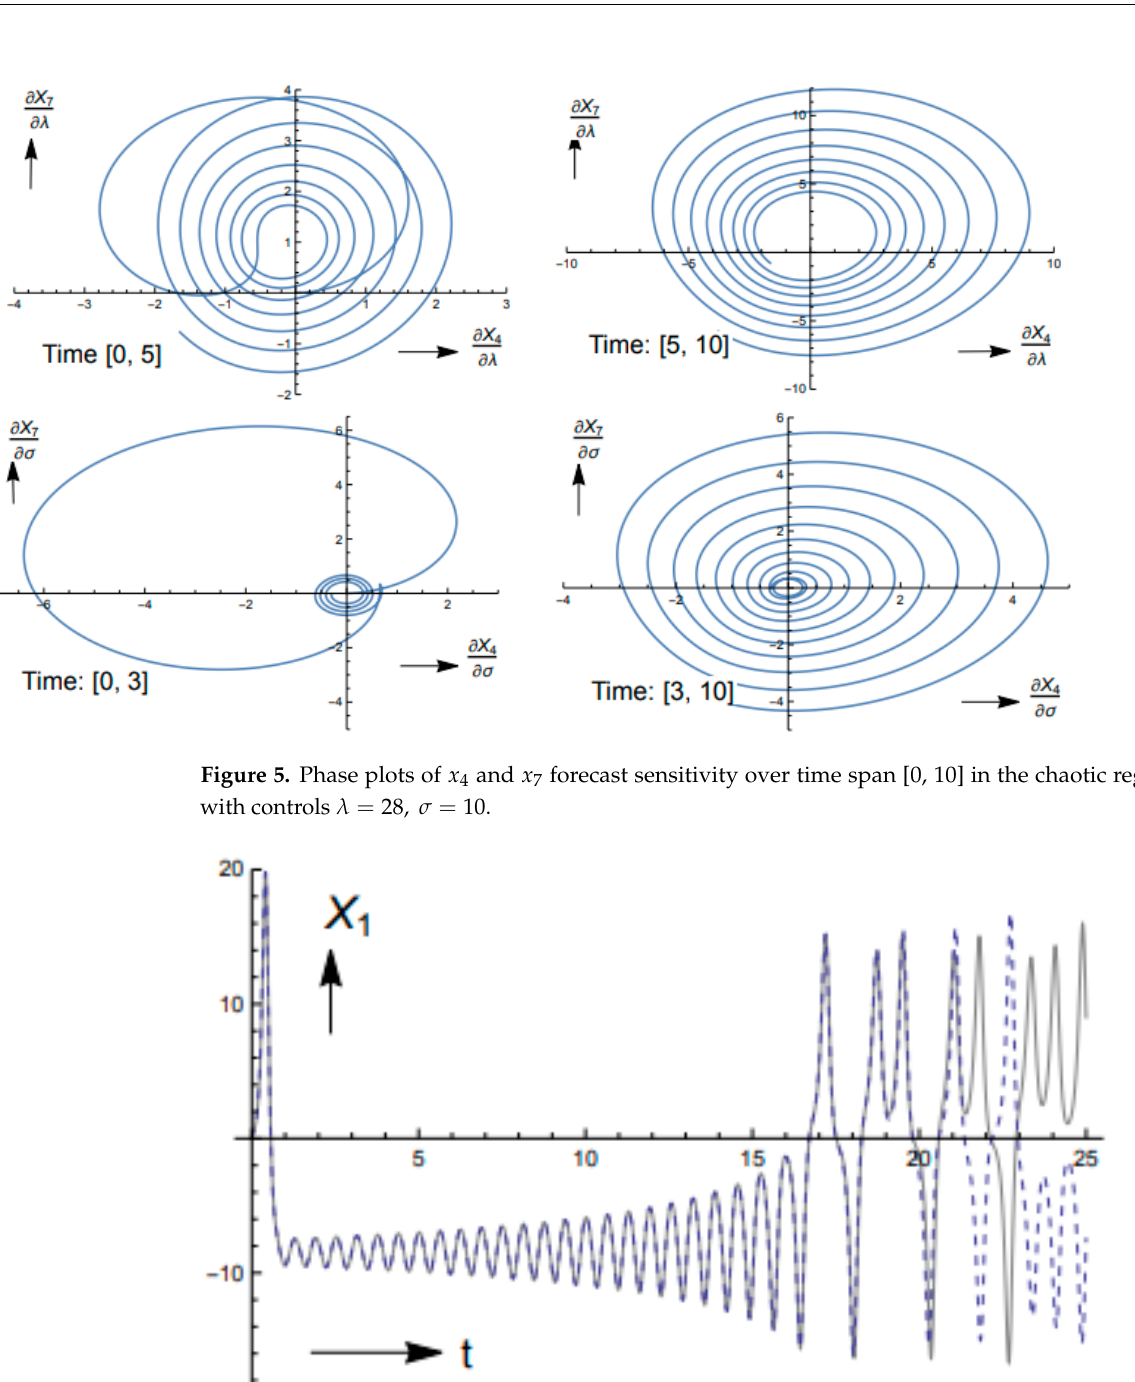
Figure 6. Extreme sensitivity of streamfunction amplitude x 1 to slight change in x 4 ( 0 ) from 1.00 to 1.05 for the chaotic regime—solid line ( x 4 ( 0 ) = 1.00) and dashed line ( x 4 ( 0 ) = 1.05 ).